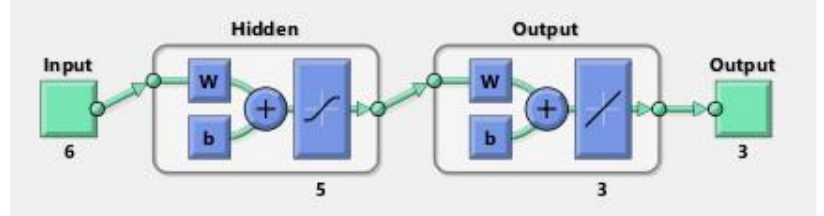
Figure 3. An illustration of the designed framework diagram.